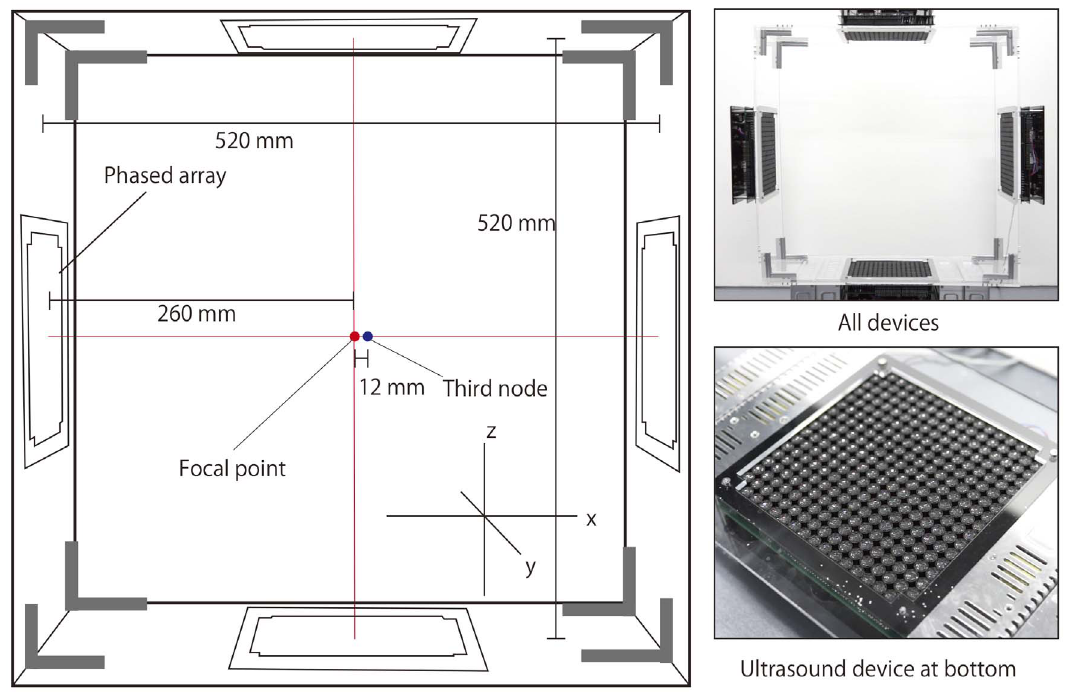
Figure 3. Illustration and photograph of system setup. The size of system is 520 mm(height) 6 520 mm(width) 6 250 mm(depth). The focal point is set in the center of workspace. The labels of axis are shown in the figure: x-axis and z-axis are parallel to the device plane and y-axis is vertical to the device plane. We inserted the particles at the third node of beams that is parallel to x-axis in the stability experiments.